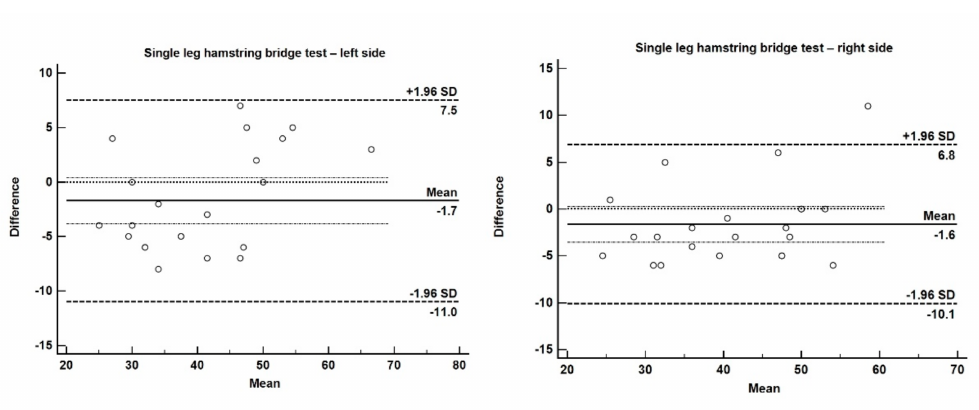
Figure 2. Bland–Altman plots for the single leg hamstring bridge test for the left and right side.